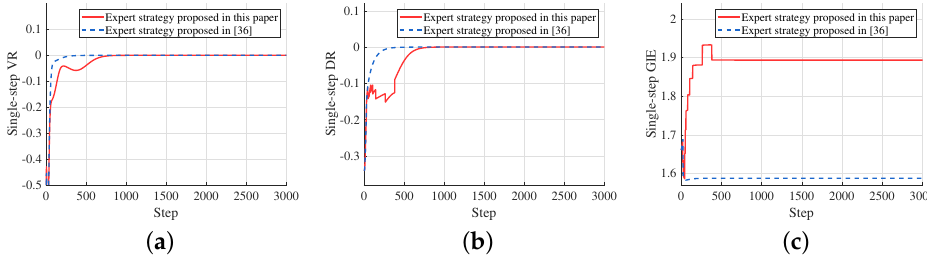
Figure 4. Variation of the single-step consistency evaluation metrics under the control of the two expert strategies in a specific episode. ( a ) Variation of the single-step VR. ( b ) Variation of the single-step DR. ( c ) Variation of the single-step GIE.